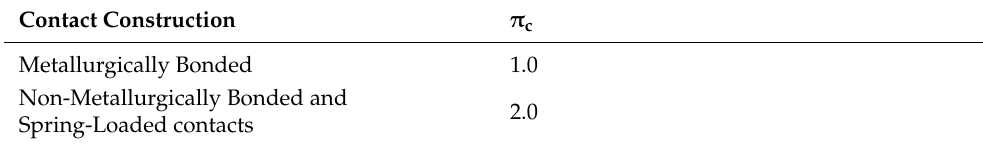
Table 4. Two contact construction factor values for use in varying environments [50,68].